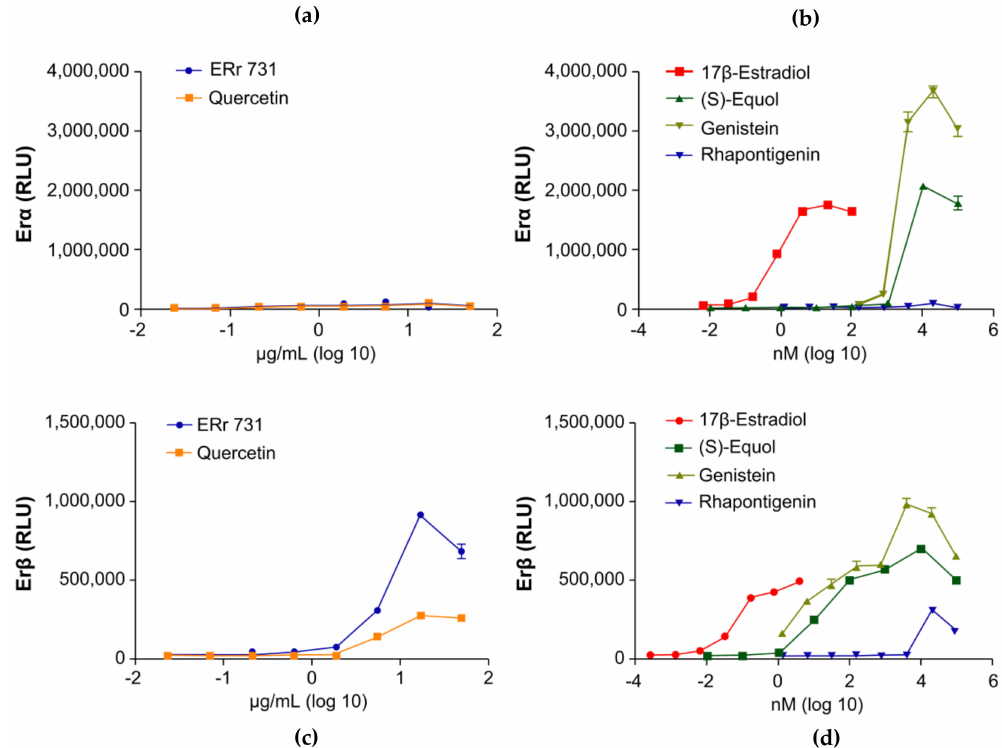
Figure 13. Effect of Rhapontic rhubarb root extract (ERr731) on activity of ( a , b ) ER α or ( c , d ) ER β compared to quercetin, estradiol, equol, genistein, and rhapontigenin. Reprinted from Wilson, M.; Konda, V.; Heidt, K.; Rathinasabapathy, T.; Desai, A.; Komarnytsky, S. Rheum rhaponticum Root Extract Improves Vasomotor Menopausal Symptoms and Estrogen-Regulated Targets in Ovariectomized Rat Model. Int. J. Mol. Sci. 2021 , 22 , 1032. © 2021 by the authors. Licensee MDPI, Basel, Switzerland . under the terms and conditions of the Creative Commons Attribution license [66].